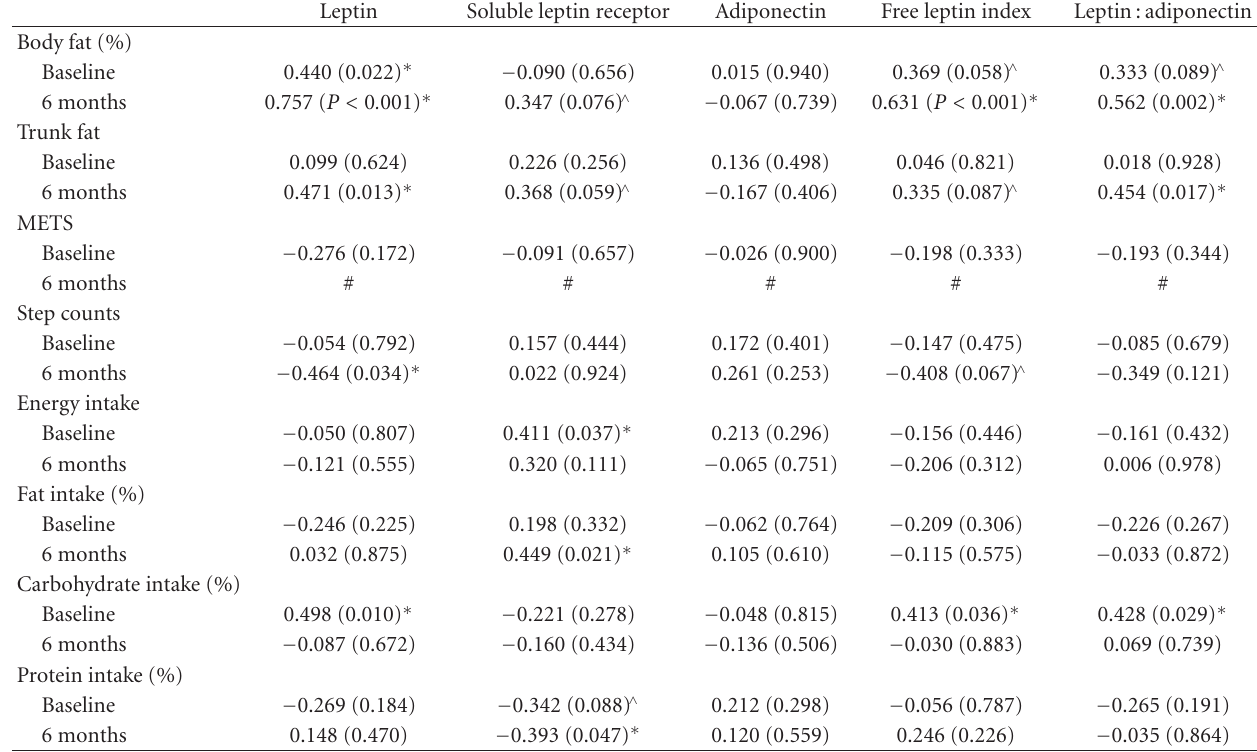
Table 5: Spearman correlations at baseline and 6 months for women between adipokines and body fat %, trunk fat, step counts, dietary intake, and peak METS from GXT (baseline only). Data are presented as rho correlation coe ffi cient ( P value).